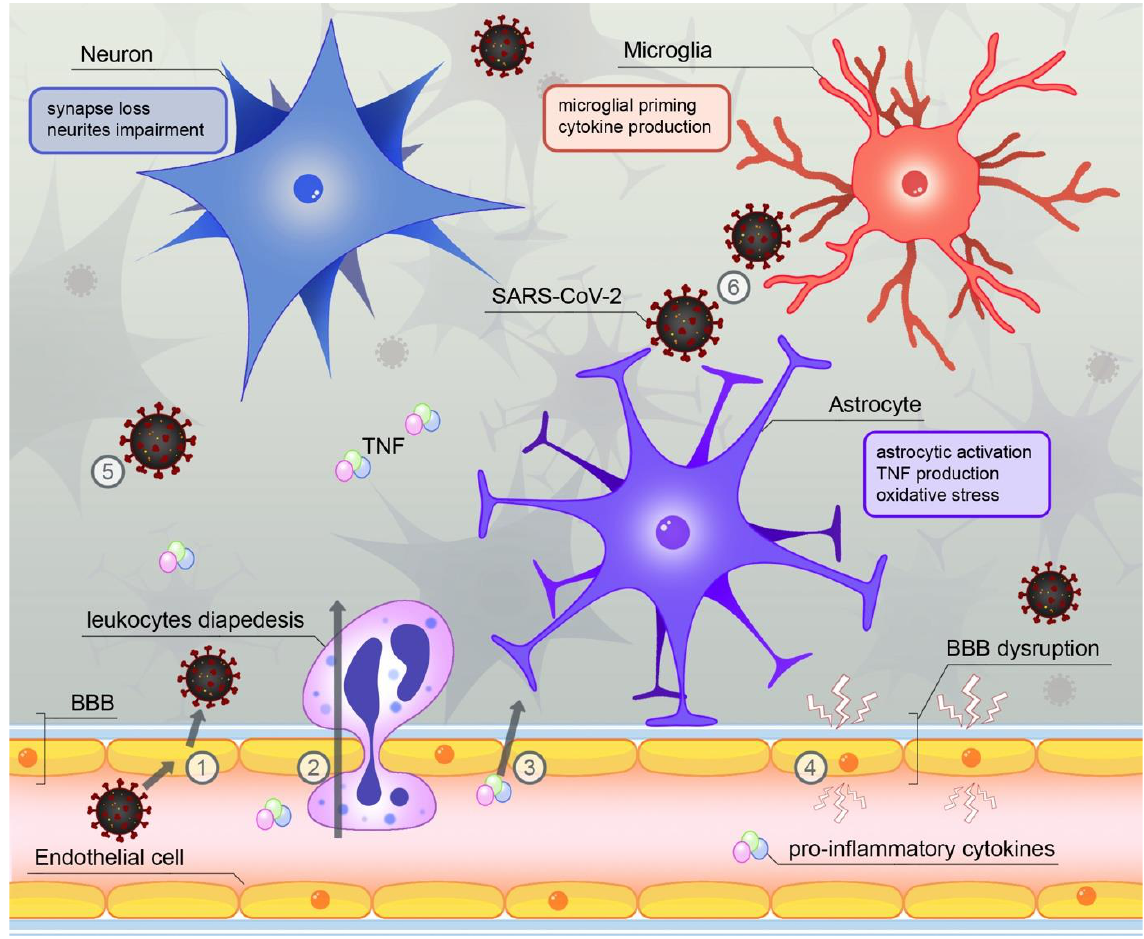
Figure 1. SARS-CoV-2 infection impacts the CNS via several potential pathways: (1) Infection of endothelial cells by viral particles present in the blood; (2) infiltration of the CNS by activated leukocytes from the bloodstream; (3) entrance of pro-inflammatory cytokines into the CNS; (4) loss of the BBB integrity due to increased immune response; (5) hypothetic direct passage of viral particles via olfactory nerve and (6) activation of pro-inflammatory phenotypes of CNS-residing cells.